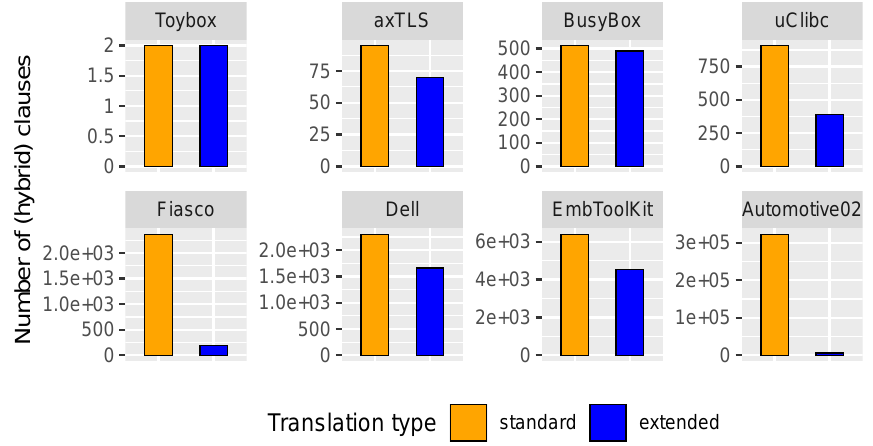
Figure 10. Number of (extended) clauses for standard and extended logic.